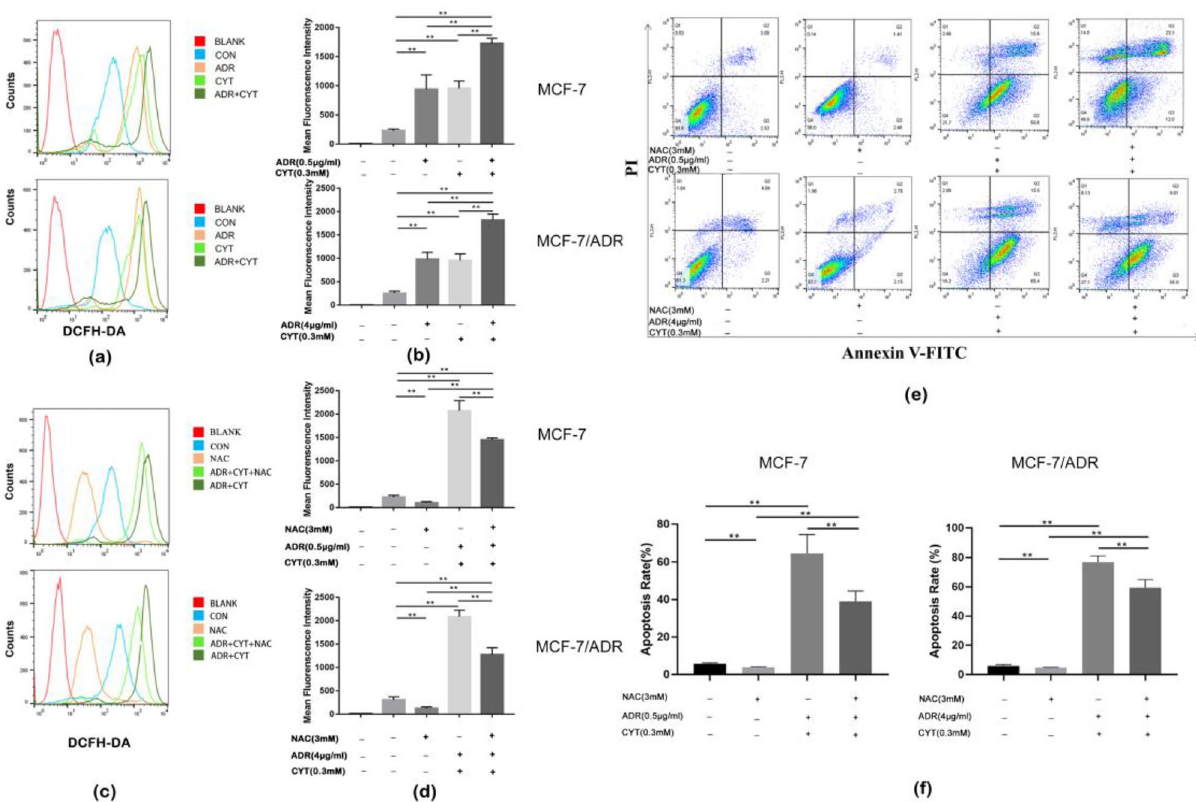
Figure 3. CYT combined with ADR increases the production of ROS in MCF-7 and MCF-7/ADR cells. ( a ) Flow cytometry results of ADR + CYT induced ROS generation in MCF-7 and MCF-7/ADR cells. ( b ) The bar chart showed the mean ± S.D. of three experiments. ** p < .01 vs control. ( c ) NAC inhibited ADR + CYT induced ROS generation in MCF-7 and MCF-7/ADR cells. ( d ) The bar chart showed the mean ± S.D. of three experiments. ( e ) NAC inhibited ADR + CYT induced apoptosis in MCF-7 and MCF-7/ADR cells. ( f ) The bar chart showed the mean ± S.D. of three experiments. ** p <